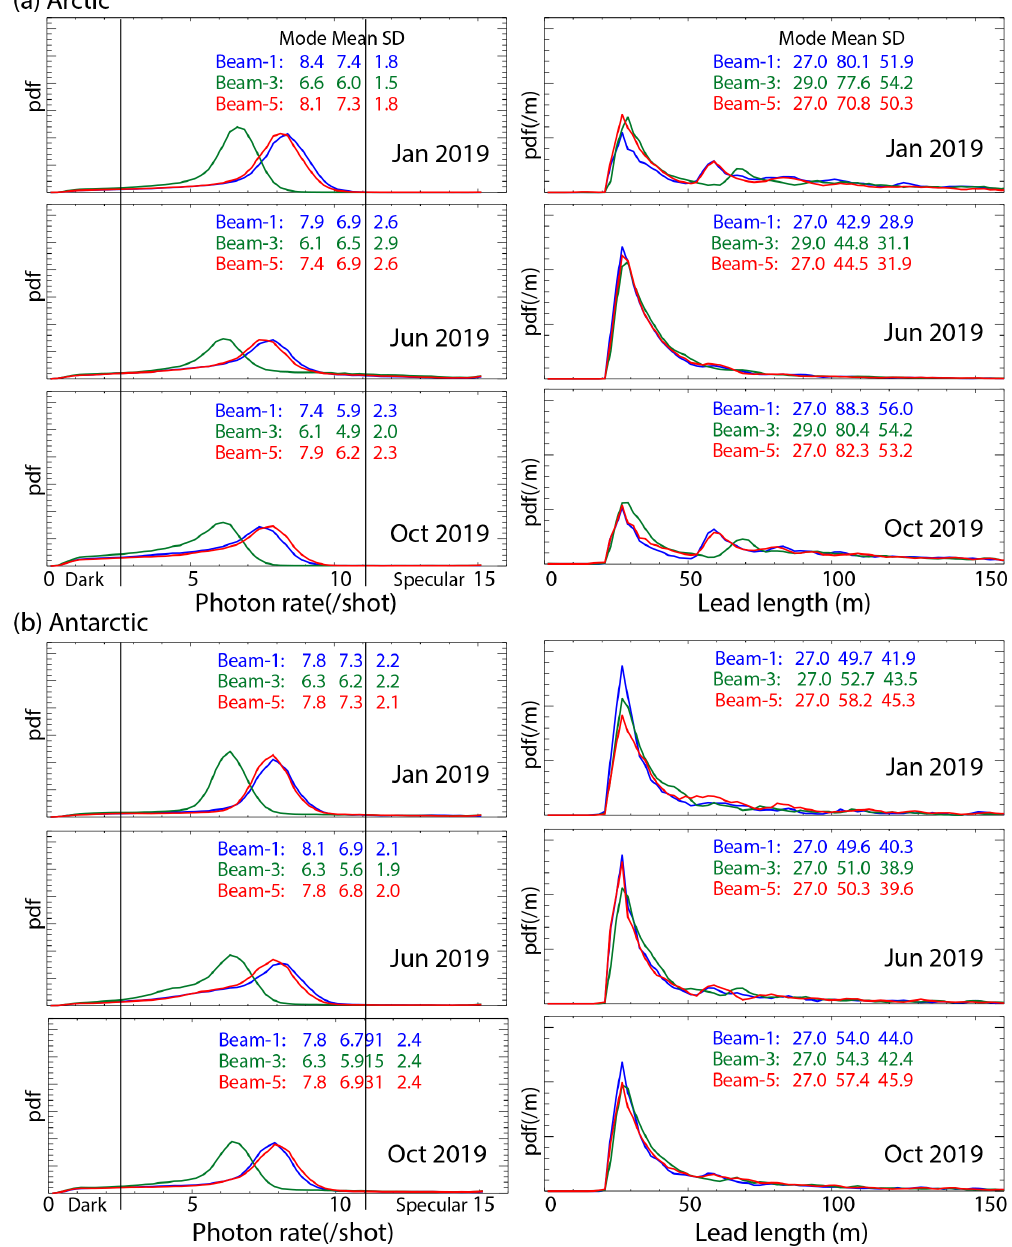
Figure 1. Distributions of photon rates of all height segments and lead lengths (strong beams) in IS-2 sea ice products of the (a) Arctic and (b) Antarctic for the months of January, June and October 2019. Numerical values show the mode, mean and standard deviation of the